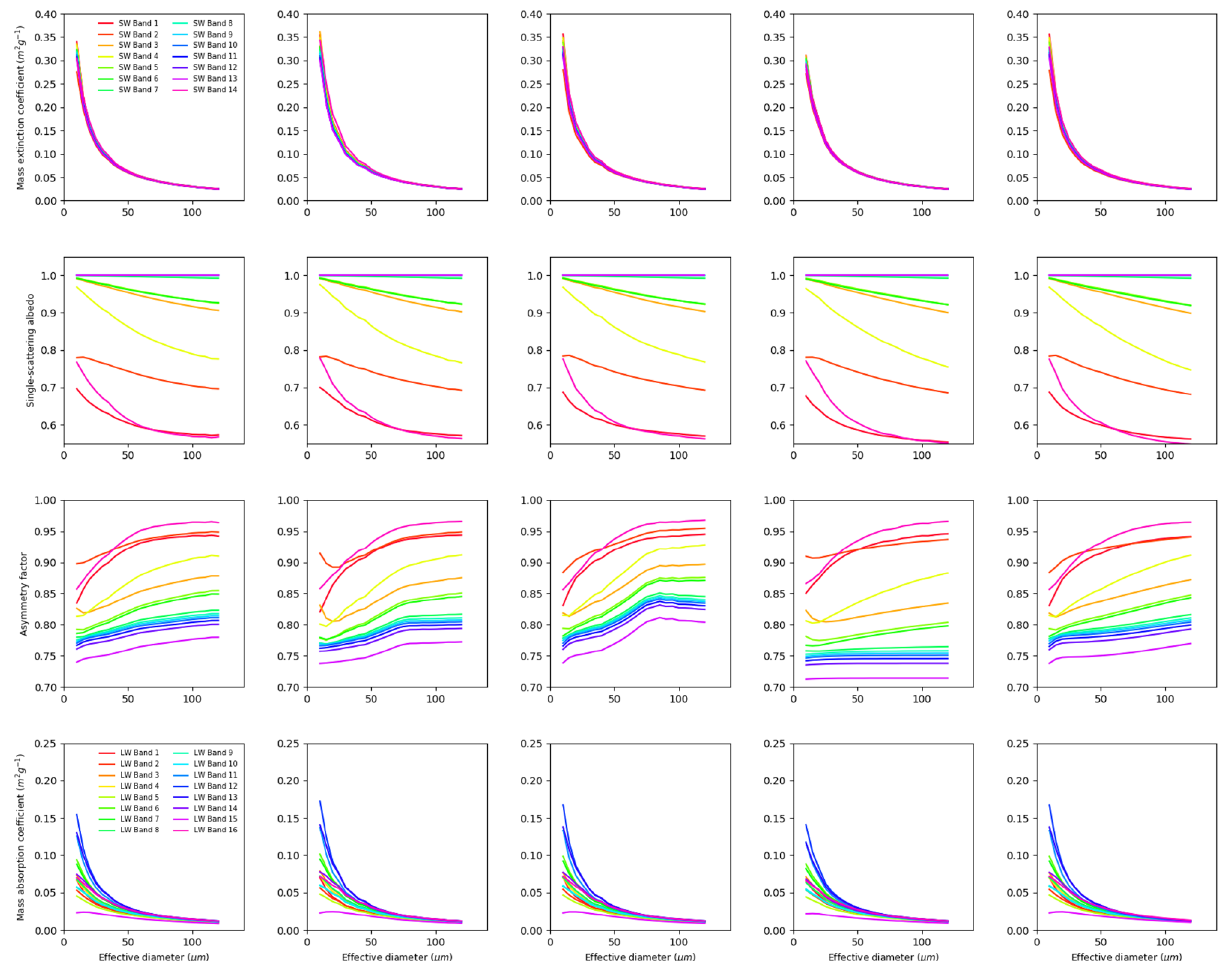
Figure 1. Ice cloud optical properties parameterized as functions of the ice particle effective diameter for various SW and LW bands. Rows from top to bottom are the mass extinction coefficient, single-scattering albedo, asymmetry factor, and mass absorption coefficient. Columns from left to right are the GHM, MLC, TDC, ASC, and SCN ice habit cases. The spectral ranges of SW and LW bands are listed in Table 2.